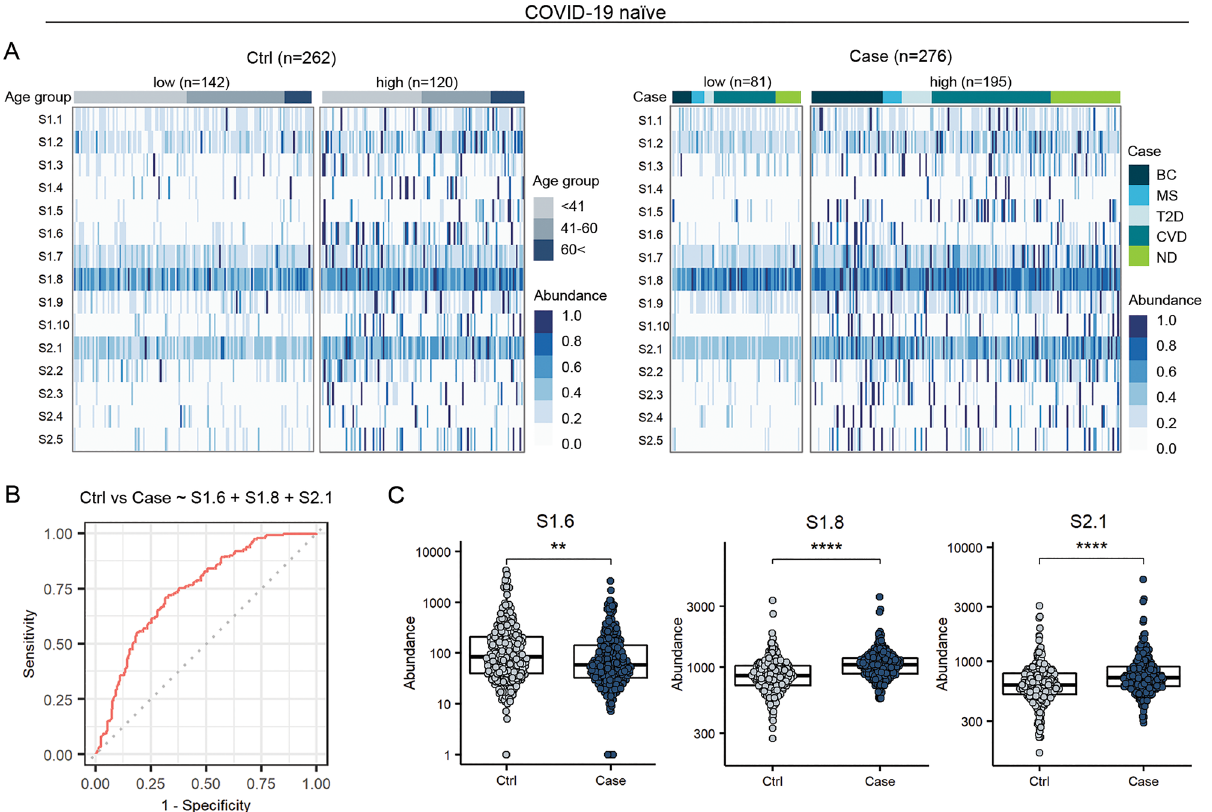
Figure 4. Antibody response to immunodominant epitopes on SARS-CoV-2 spike protein as predictors of ill health. (A) Individual immunoprofiles of SARS-CoV-2 S protein epitopes in COVID-19 naïve subjects, grouped into Ctrl (n = 262) or Case (with presented chronic diseases) (n = 276). “low” or “high”—subjects with relatively lower or higher overall response to S, calculated based on abundance of IgG-bound peptides containing the epitopes (S1.1 to S2.5) on SARS-CoV-2 spike protein (see “Methods”). x-axis—individual samples sub- grouped by Abundance (blue colour bar) where colour intensity shows individual abundance of IgG-bound peptides containing epitopes of spike normalised with 97.5th percentile value for visualisation. Age (grey colour bar) in Ctrl; y-axis—epitopes on Spike; S1 epitopes on subunit 1 of S; S2 on subunit 2 of S; COVID-19 naïve Case sub-groups: BC breast cancer (n = 57), MS multiple sclerosis (n = 20), T2D type 2 diabetes (n = 25), CVD —cardiovascular disease (n = 114), ND —neuropsychiatric disorders (n = 60). ( B) Multivariable logistic regression analysis was used to describe the associations of epitope seroresponse predictors with the acute and/ or chronic disease outcomes. Figure shows receiver operating characteristic (ROC) curve of using response to epitopes S1.6, S1.8, and S2.1 on training data (80% subset, i.e. 431/538 samples) for classifying Case (n = 276) vs Ctrl (n = 262). Area under curve (AUC) = 0.74 with 95% CI = (0.70…0.79). On validation with test set of 20% (107/538) samples, the select model classified samples into Case vs Ctrl with balanced accuracy of 62.0% for “low” group and 65.2% for “high” group (Fig. S10C). ( C) Separately, antibody response to epitope S1.6 was identified as prevalent among Ctrl group subjects, whereas immune responses to epitopes S1.8 and S2.1 were prevalent among Case group in COVID-19 naïve cohort. Mann–Whitney U test, **p < 0.01; ****p < 0.0001. Group sizes: Ctrl (n = 262), Case (n = 276); abundance — abundance of IgG-bound peptides containing respective